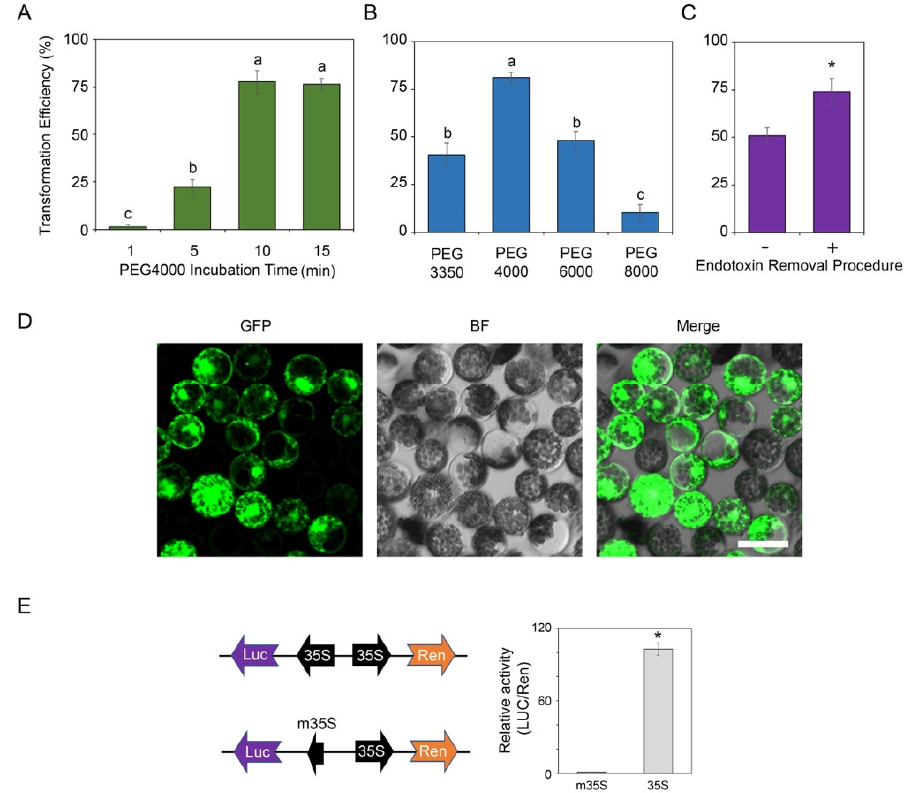
Figure 2. Transformation of T. fournieri protoplast. ( A ) The effect of polyethylene glycol (PEG, molecular weight: 4000) incubation time on the protoplast transformation efficiency. Significant analysis was performed by ANOVA followed by Tukey post hoc test ( p < 0.05). Error bars indicate the standard deviations of five biological replicates. ( B ) The effect of molecular weight of PEG on the protoplast transformation efficiency (Incubation time: 10 min). Significant analysis was performed by ANOVA followed by Tukey post hoc test ( p < 0.05) Error bars indicate the standard deviations of five biological replicates. ( C ) Removing (+) endotoxin or not (-) from the plasmids influences the protoplast transformation rate. PEG4000 was used and the incubation time was 10 min. About 1 mL protoplasts (~10 6 ) was used for this analysis. Asterisk (*) indicated the significant difference between two treatments by Student’s t -test ( p < 0.05). Error bars indicate the standard deviations of five biological replicates. ( D ) A confocal image showing the torenia protoplast after transformation using the 35S:GFP vector. PEG4000 was used, the incubation time was 10 min, and the endotoxin was removed from the vectors. BF: Confocal brightfield channel; Merge: Merge of GFP and BF channel. Scale bar = 25 µ m. ( E ) Luciferase activity assay in torenia protoplast. Vector constructs were indicated in the left panel. LUC, Firefly Luciferase. m35S, a mini-35S promoter (48 bp). Ren, Renilla reporter for normalization. Relative LUC/Ren activities (right panel) indicated the levels of gene expression activated by m35S or full length 35S promoter. Asterisk (*) indicated the significant difference between two constructs by Student’s t -test ( p < 0.05). Error bars indicate the standard deviations of five biological